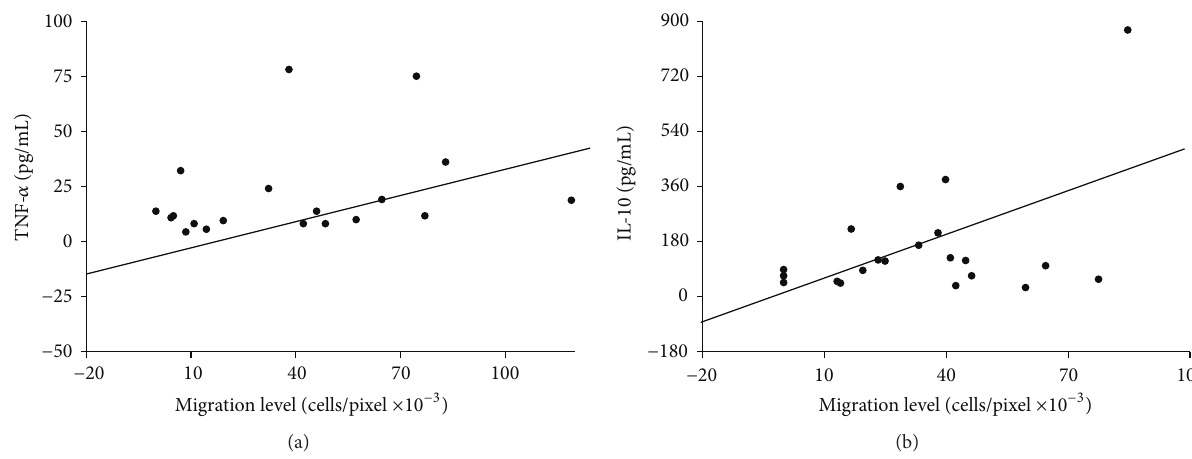
Figure 3: Pearson correlation analysis of postoperative induction of colon cancer cell migration and TNF- 𝛼 and IL-10 levels. (a) The effect of peritoneal fluid on the migration capacity correlated with its TNF- 𝛼 level on the second postoperative day. Pearson 𝑟 = 0.507 ; 𝑝 = 0.032 . (b) The effect of peritoneal fluid on the migration capacity correlated with its IL-10 levels on the first postoperative day. Pearson 𝑟 = 0.537 ; 𝑝 = 0.018 .